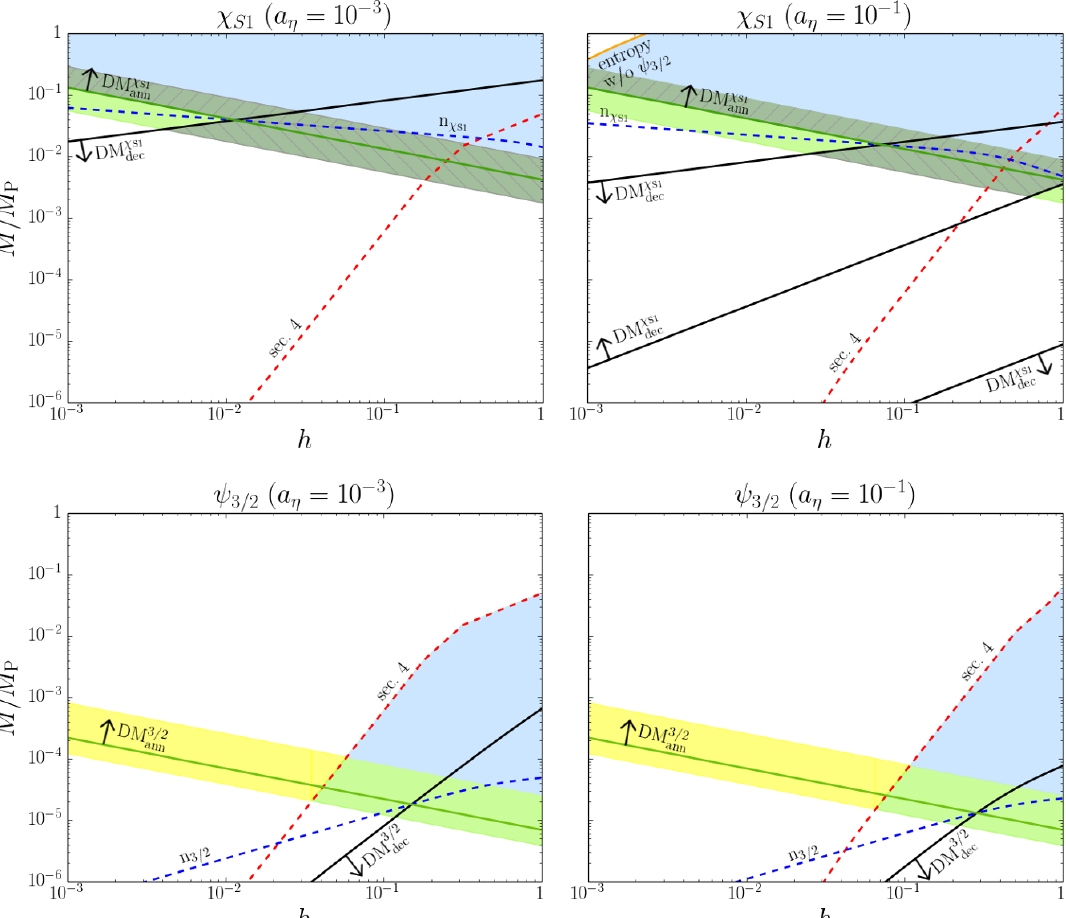
Figure 5 . All the constraints on the ISS parameters M and h for dark matter production from either direct decays DM dec or decays followed by annihilations DM ann for (cid:31) S 1 and | for a thermal 3 = 2 cross section h (cid:27) ann v M(cid:28)l i = 10 (cid:0) 7 GeV (cid:0) 2 and for small (large) coupling a (cid:17) = 10 (cid:0) 3 ( a (cid:17) = 10 (cid:0) 1 ). The arrows for the green and black lines point in the direction where (cid:10) (cid:31) h 2 < 0 : 12. We hatched the d areas where (cid:10) (cid:31) h 2 (cid:20) 0 : 12 is obtained for decays before BBN, essentially the upper green bands. d Also, notice that the blue shaded regions combine with the yellow bands for (cid:31) S 1 or to form the 3 = 2 green regions. That is, the yellow band for (cid:31) S 1 does not appear separately from the green region, but is essentially \hidden" behind the green region. For one can still see part of its yellow 3 = 2 band because the red curve which applies for is more constrained than the orange curve for 3 = 2 (cid:31) S 1 . A more careful explanation is given in the main text.